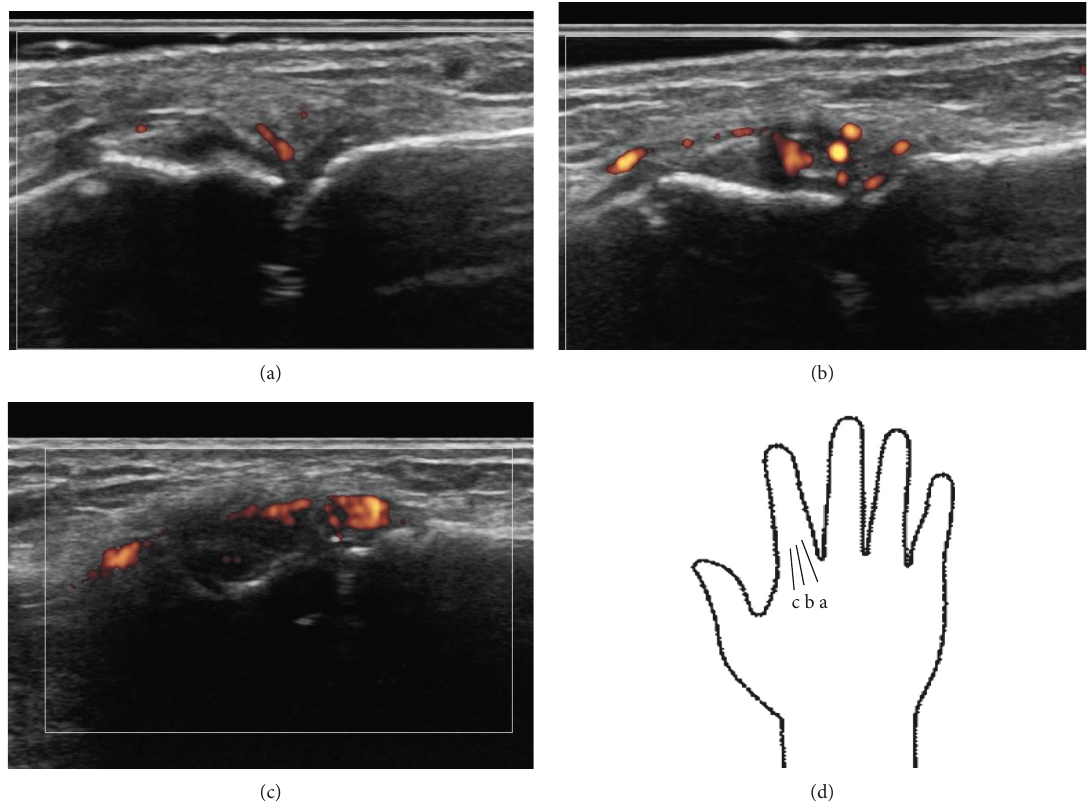
Figure 1: Ultrasonography of the metacarpophalangeal joint of the right index finger. No remarkable findings were seen on a midline echo (a), but synovial fluid and power Doppler signals were noted on the radial-shifted view (b) and